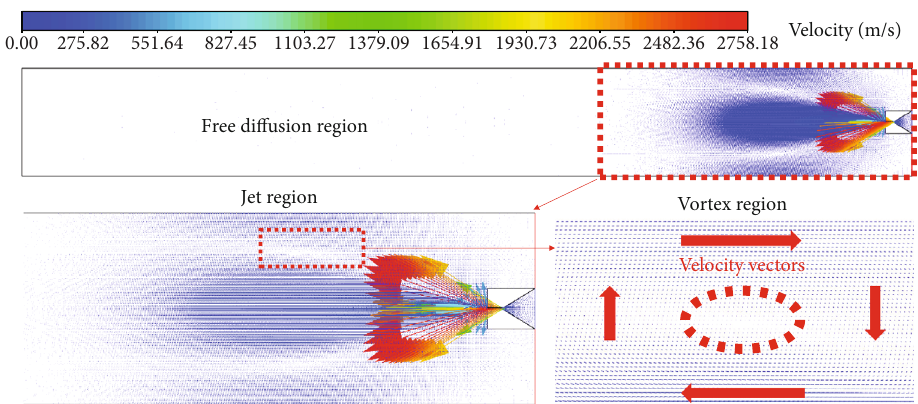
Figure 5: The type of methane-air jet mixing.